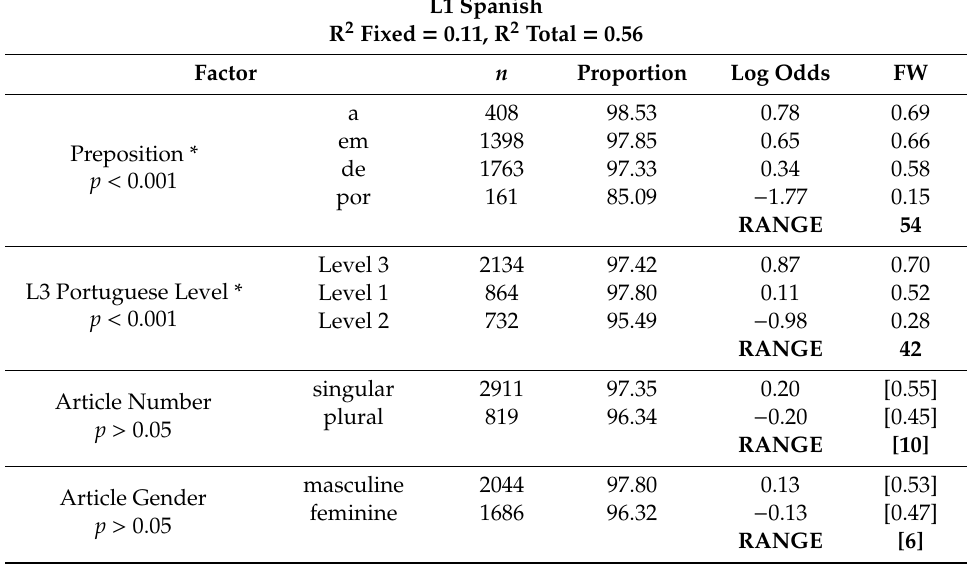
Table 11. Logistic regression of factors conditioning the realization of obligatory preposition + article contraction in L3 Portuguese for L1 Spanish speakers.